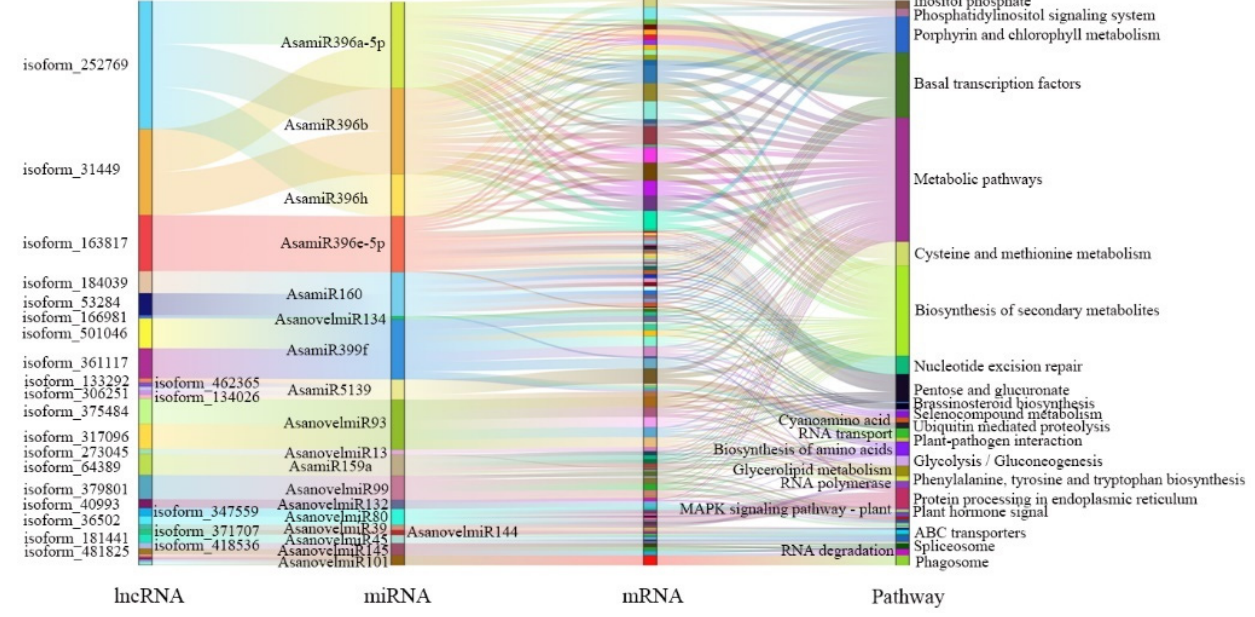
Figure 8. Sankey diagram of eTM-KEGG network in garlic somatic embryogenesis.